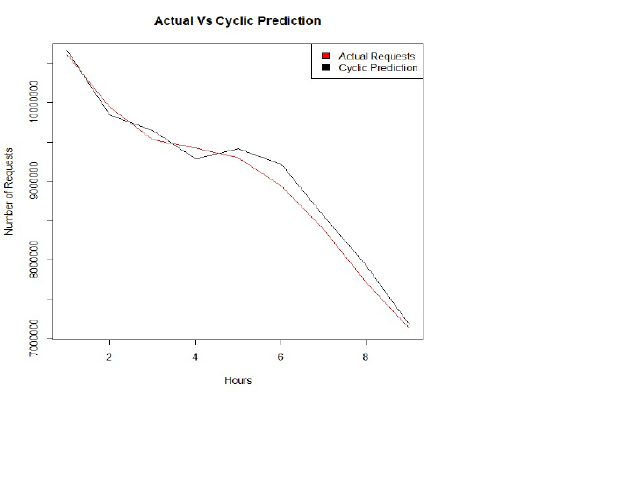
Figure 2. Actual VS Cyclic